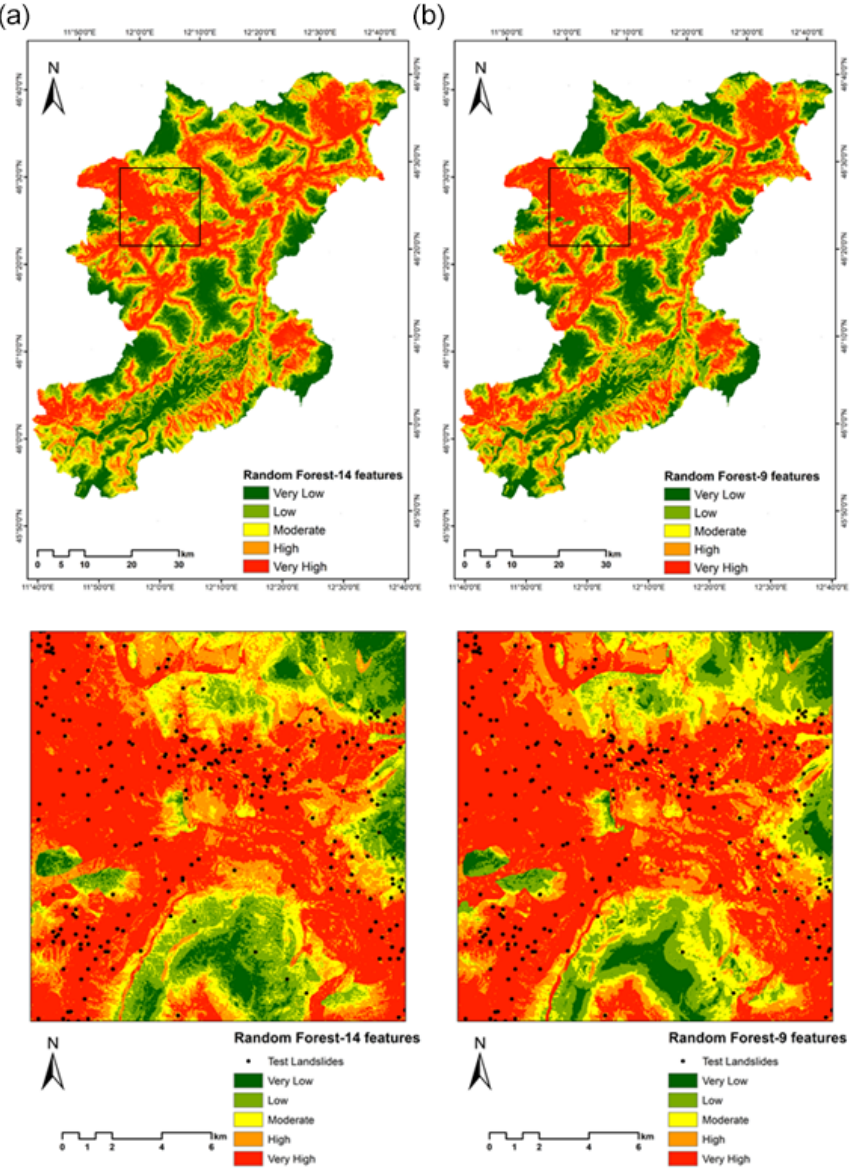
Figure 8. LSMs derived using the random forest approach for (a) 14 landslide features and (b) 9 landslide features (black square represents the enlarged